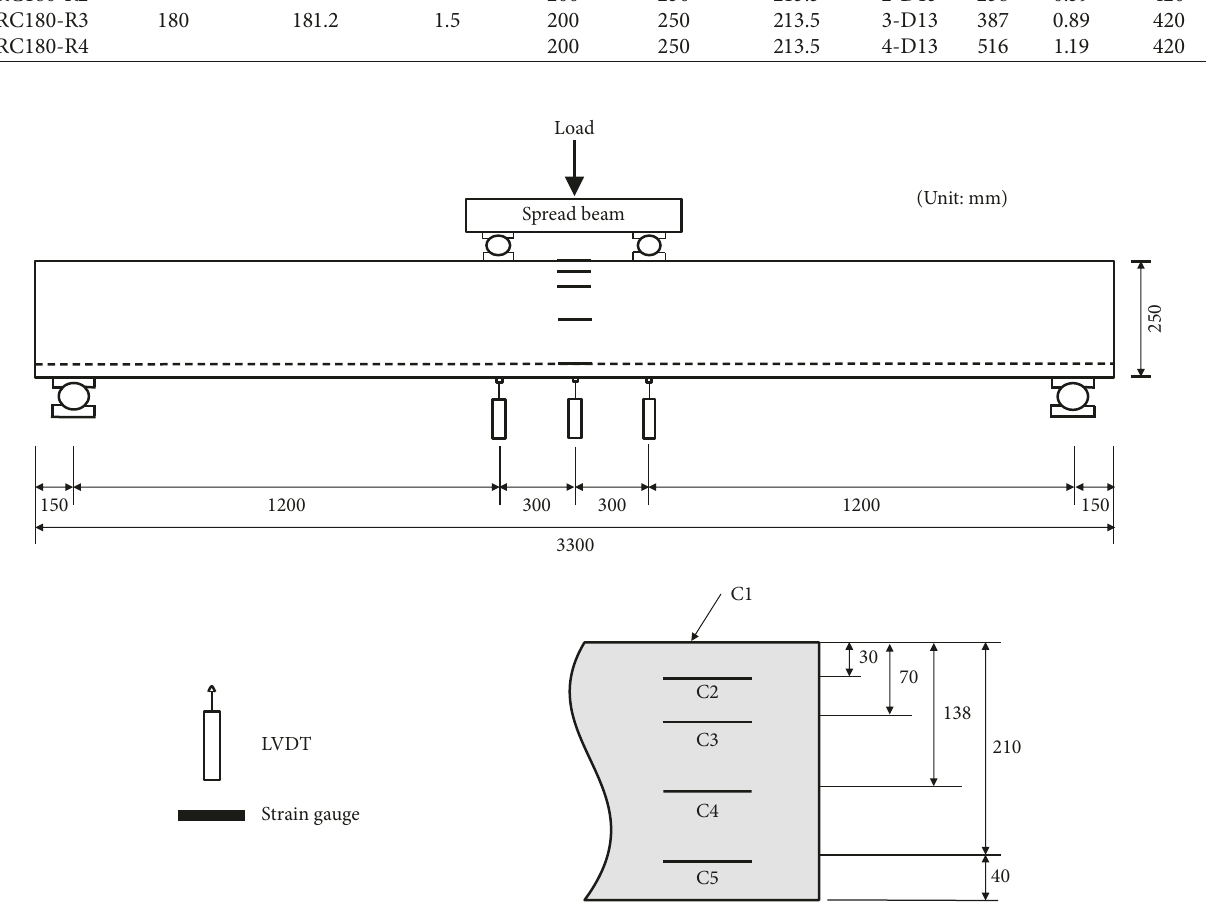
Figure 7: Instrumentation used for the flexural tests of the